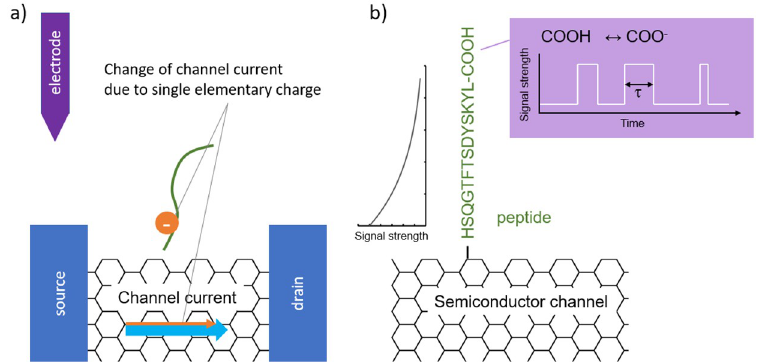
Fig 2. The functioning of an electrical sensor for reprotonation-deprotonation. (a) Illustration of the modulation of the channel current by an elementary charge in an electrolytically gated FET. (b)Illustration of the reading out of reprotonation-deprotonation behavior of a peptide by a field effect transistor device. Here, a carbon nanotube device example is given. Signal strength decreases exponentially with distance from the channel’s surface. The pKa can be deduced from the observed average